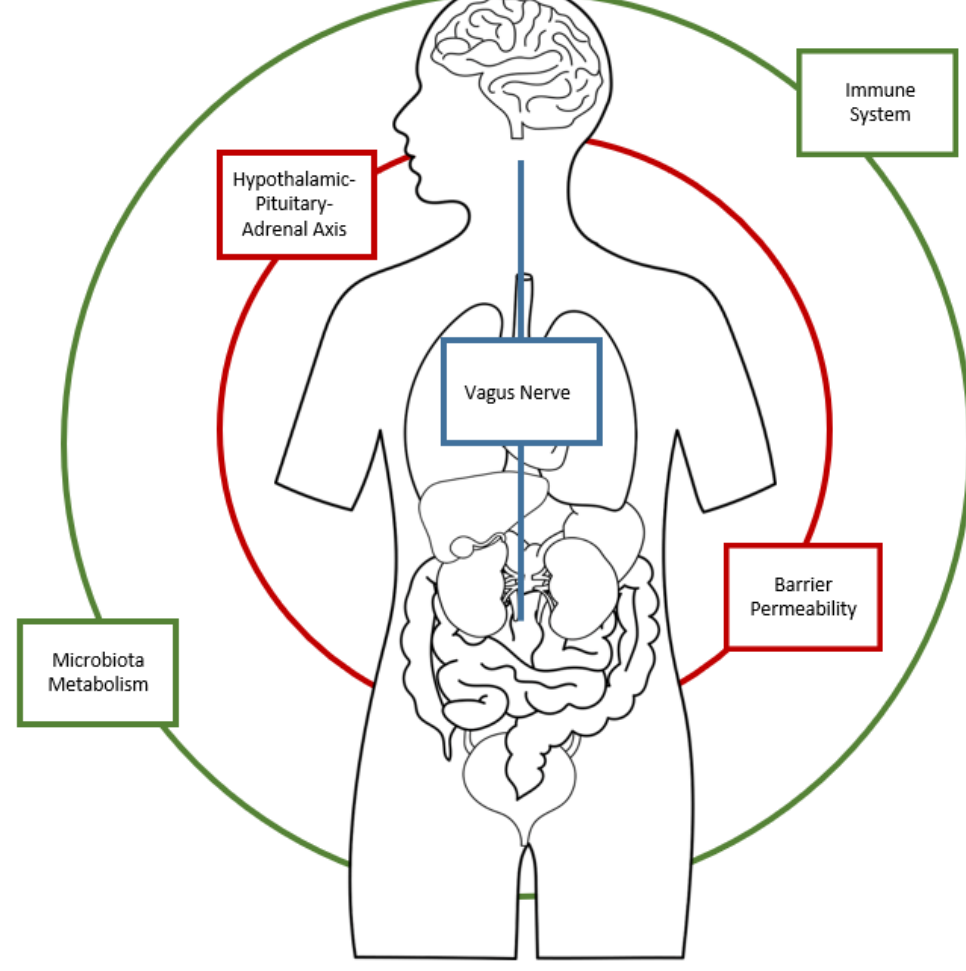
Figure 1. The Microbiota–Gut–Brain axis.